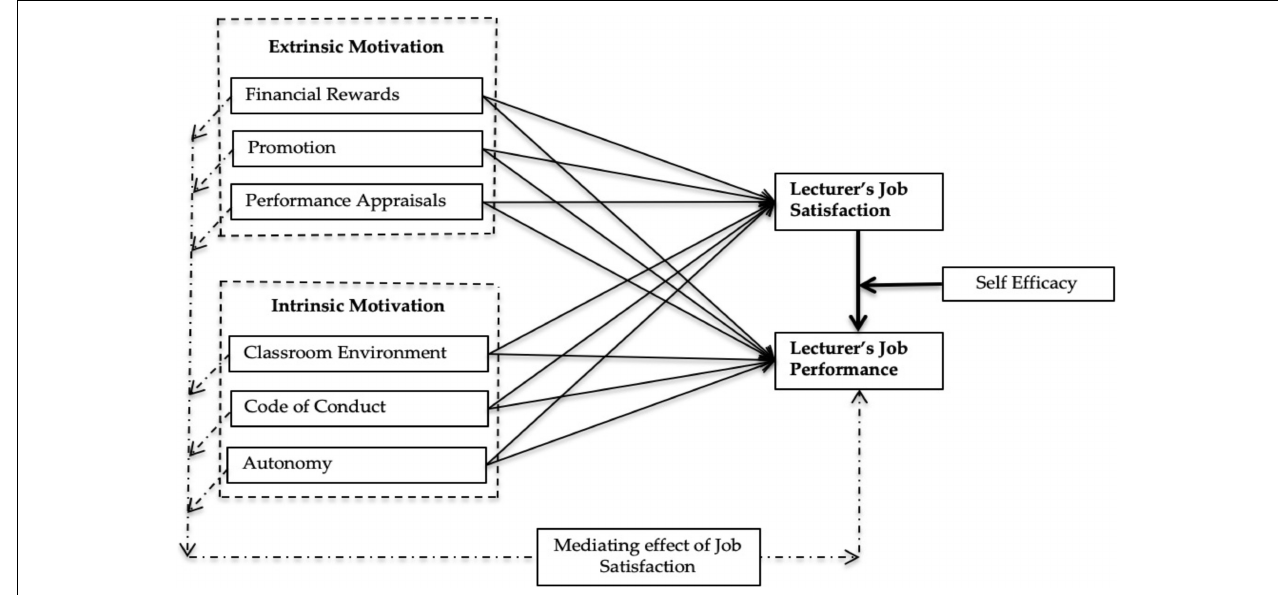
FIGURE 1 | Research